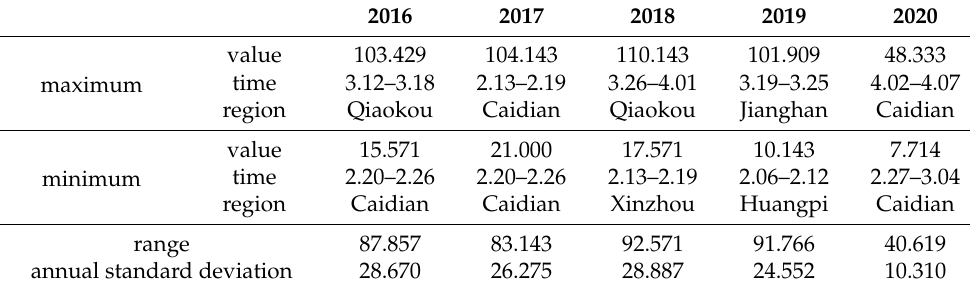
Table 5. NO 2 maximum/minimum statistics from 2016 to 2020.